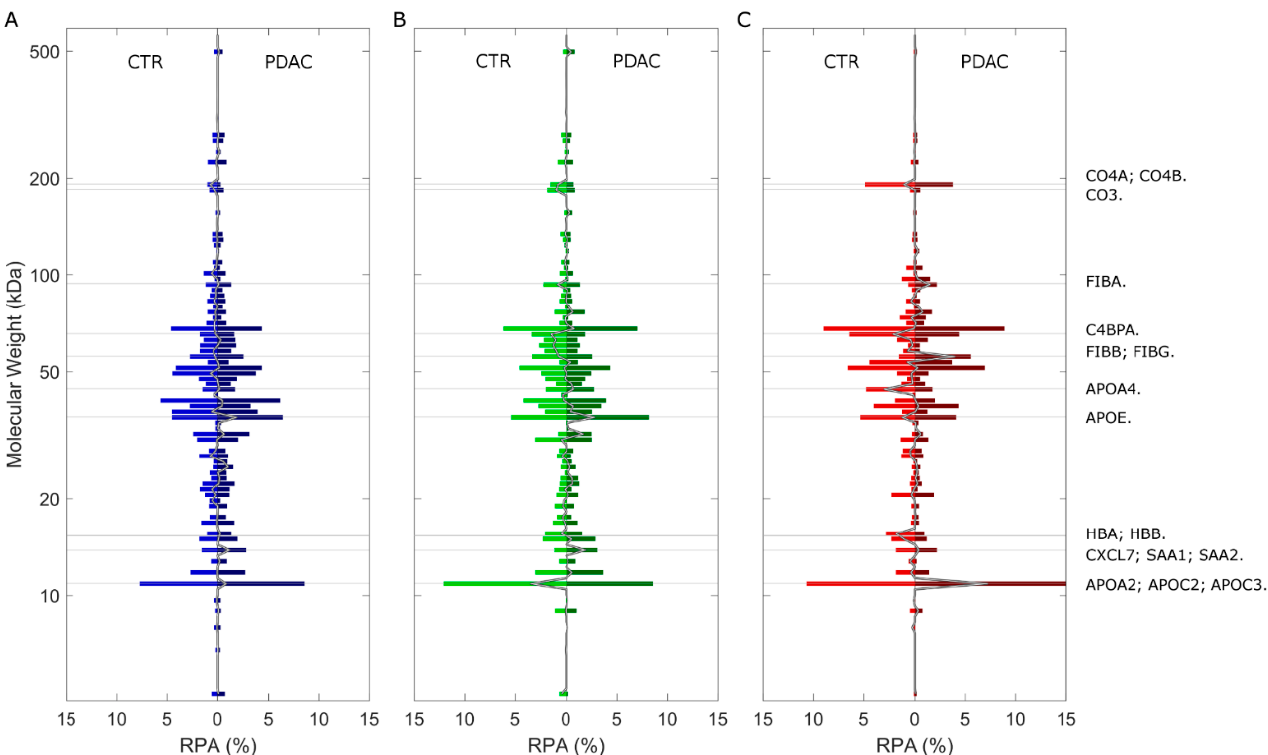
Figure 3. Molecular weight distributions of the detected corona proteins on ( A ) L 1 , ( B ) L 2 and ( C ) L 3 , for non-oncological (left) and PDAC (right) samples. Arithmetical differences between PDAC and CTR distributions are shown as solid vertical lines and proteins contributing most to such differences are listed on the right and located according to their molecular weight.